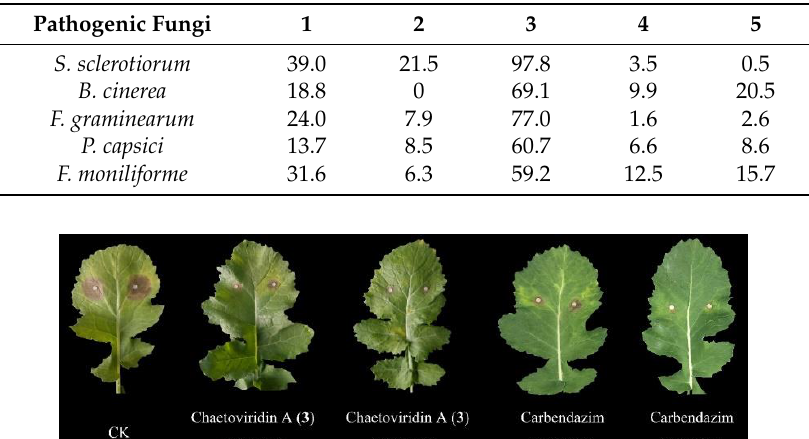
Table 3. Inhibition rates (%) of compounds against five phytopathogenic fungi.